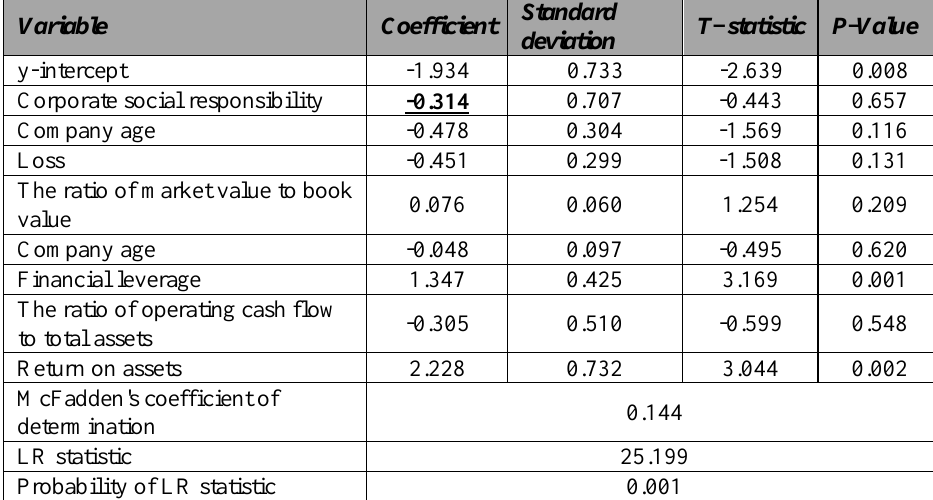
Table 10. Second model’s estimation